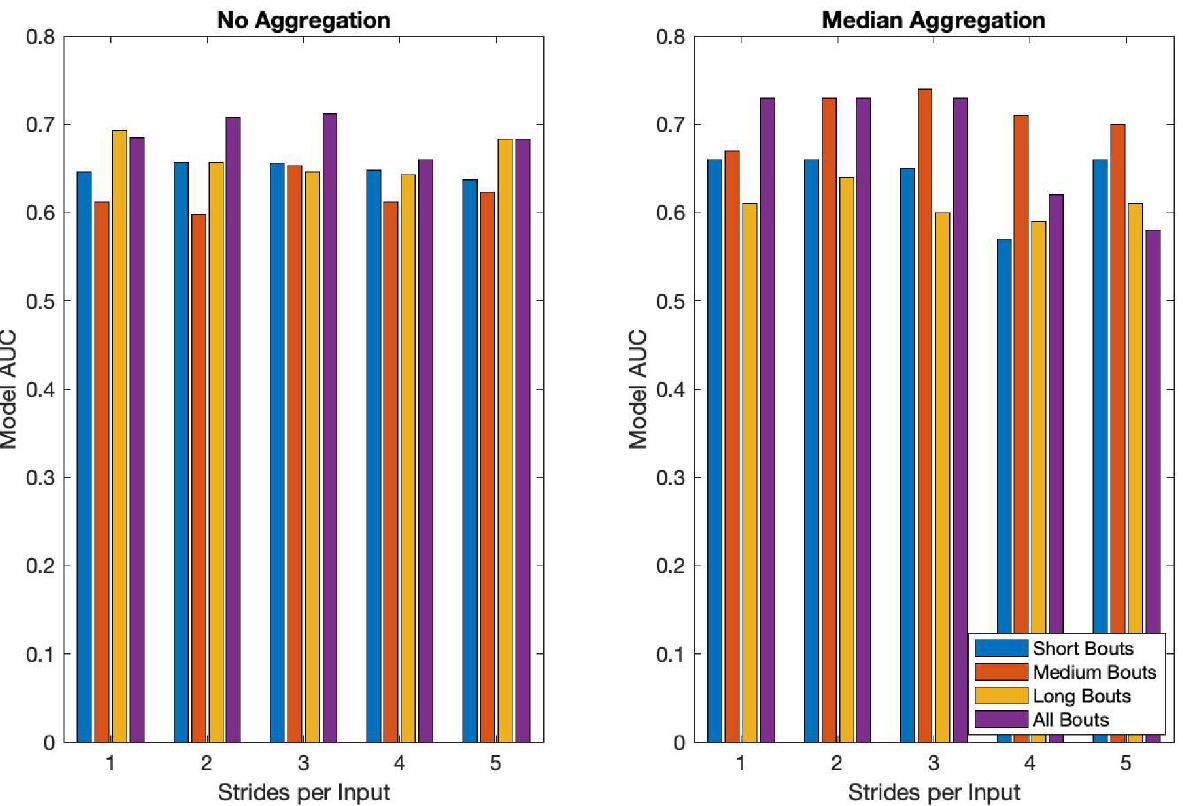
Fig 3. Fall risk classification model AUC for best performing deep learning model from short, medium, long, and all walking bouts for 1–5 inputs per stride without aggregation (left) and with median aggregation